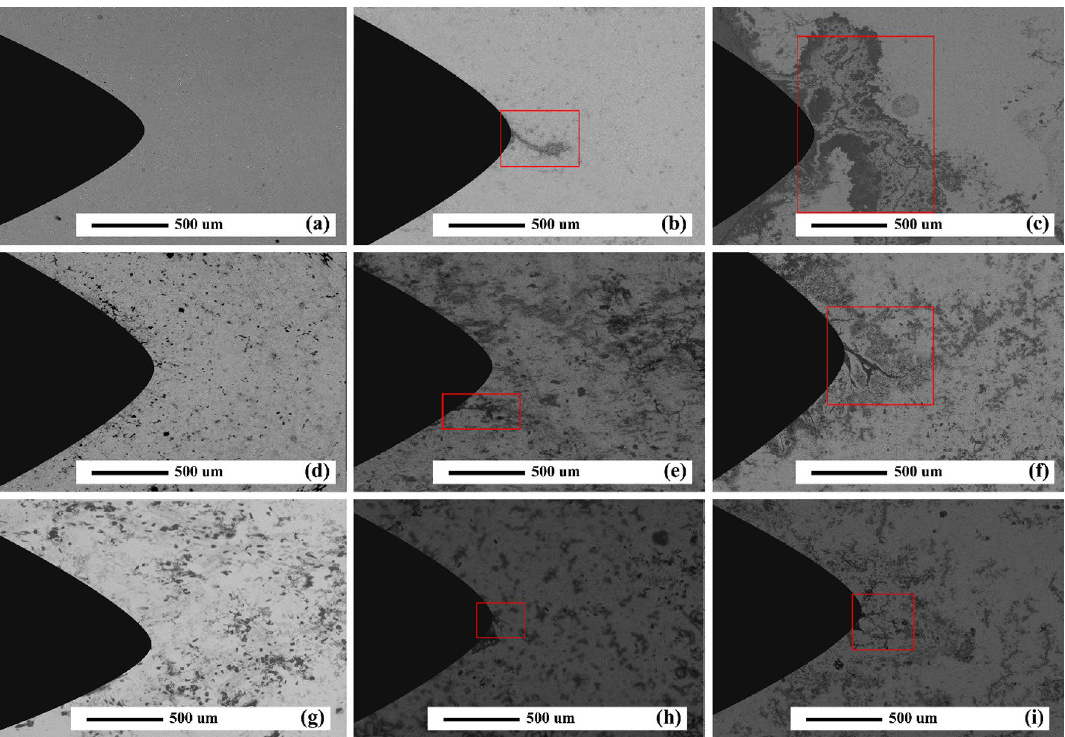
Figure 11. SEM micrographs of as-cast samples after thermal cycles at 350 °C: ( a ) unreinforced alloy after 300 cycles, ( b ) unreinforced alloy after 600 cycles, ( c ) unreinforced alloy after 900 cycles, ( d ) AZ31/5%SiC after 300 cycles, ( e ) AZ31/5%SiC after 600 cycles, ( f ) AZ31/5%SiC after 300 cycles, ( g ) AZ31/10%SiC after 300 cycles, ( h ) AZ31/10%SiC after 600 cycles, and ( i ) AZ31/10%SiC after 900 cycles.